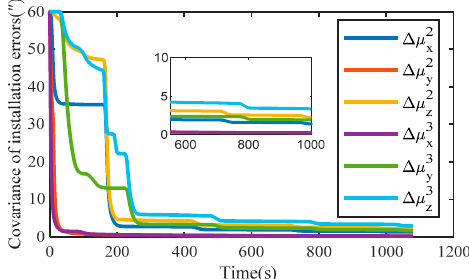
Figure 8. The covariance of installation errors is obtained by simulation.